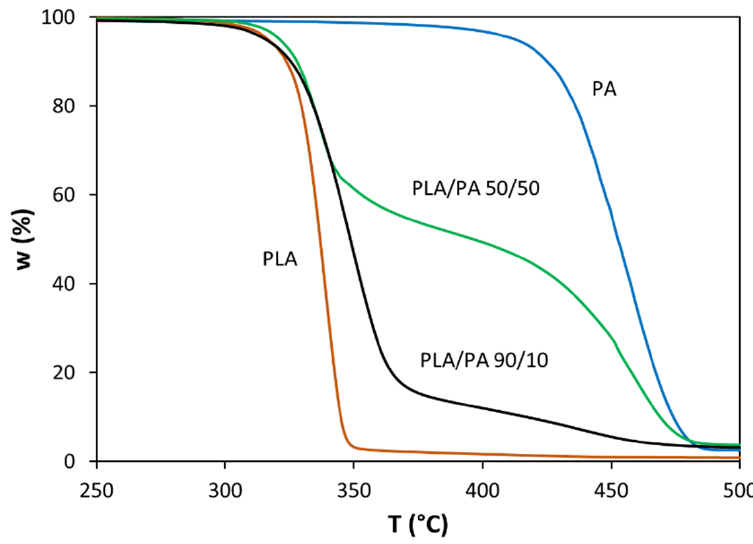
Figure 1. TG curves (i.e., variation in residual weight as a function of temperature) for PLA, PA, and bioblends containing 50% and 90% PLA (nominal heating rate = 10 K/min).